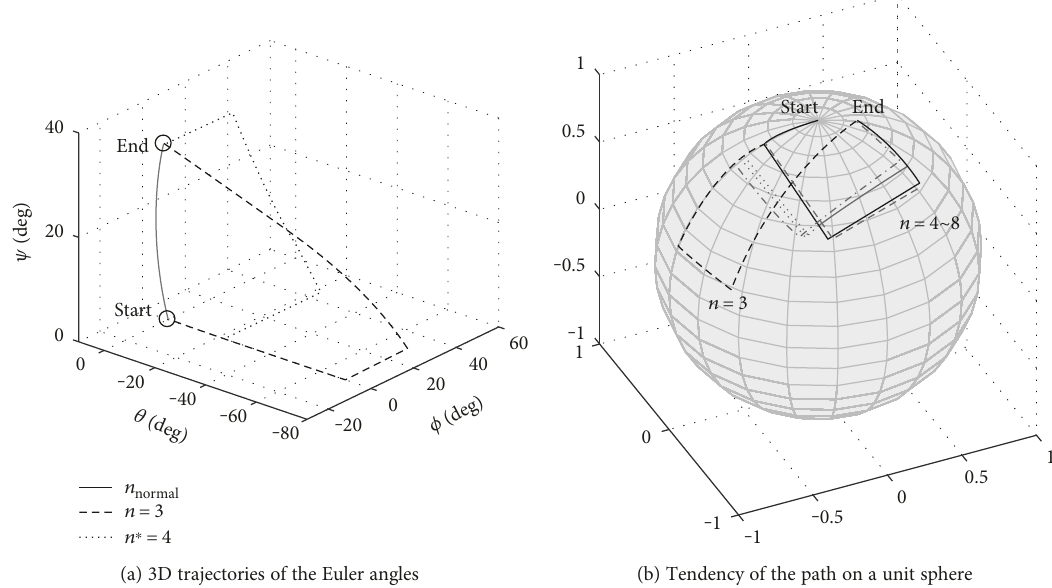
Figure 5: 3D trajectories and tendency descriptions for case 2. Table 3: Initial and obtained sets of a target attitude for case